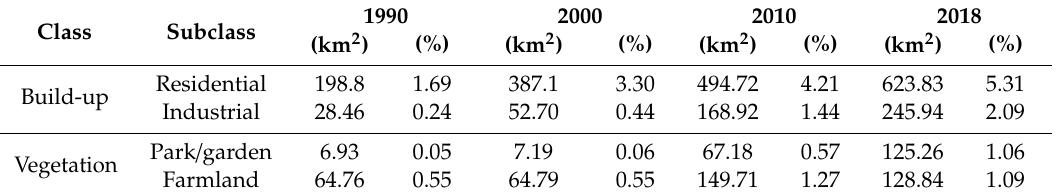
Table 4. LULC classes estimation (in km 2 and percentage) for the years 1990,2000,2010, and 2018 1 . 1990 Class Subclass Residential Build-up Vegetation